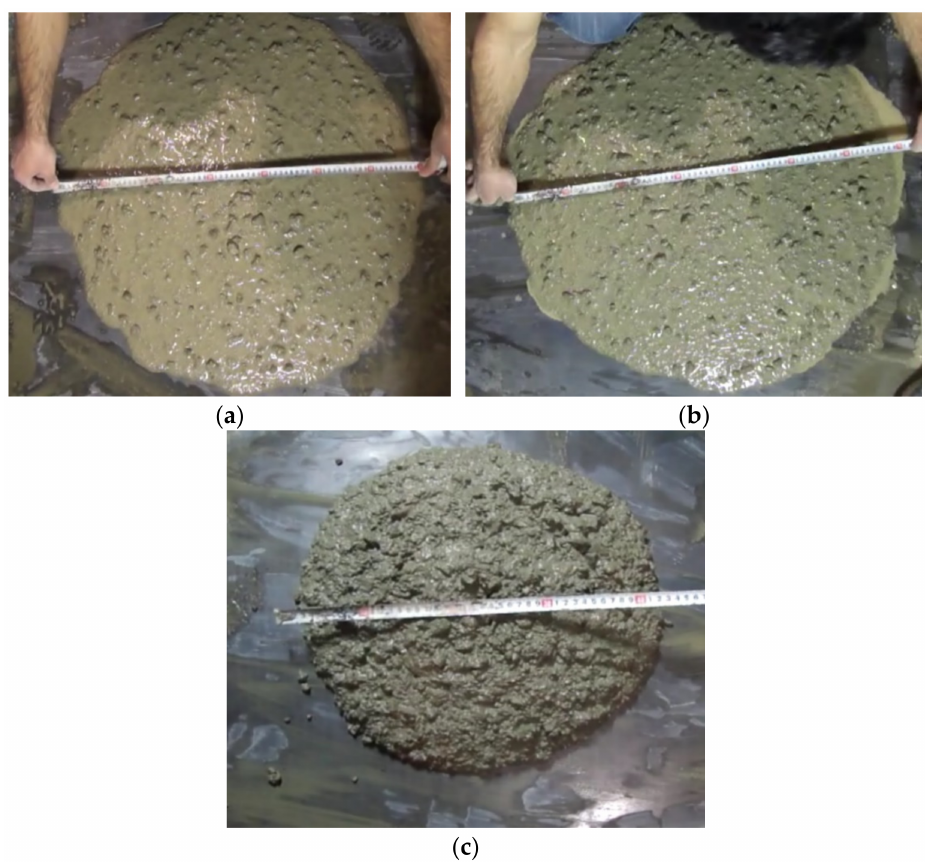
Figure 2. Different slump values in: ( a ) Instant slump, ( b ) 10 min slump, ( c ) 50 min slump